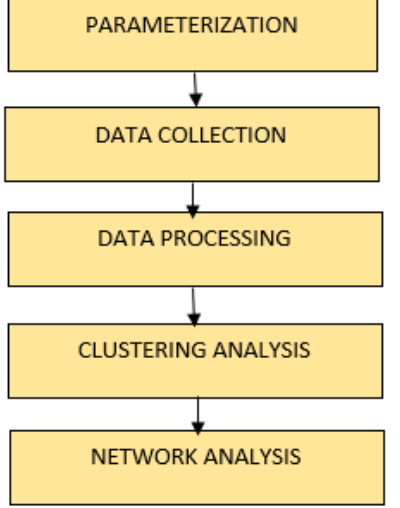
Figure 1 Flowchart of